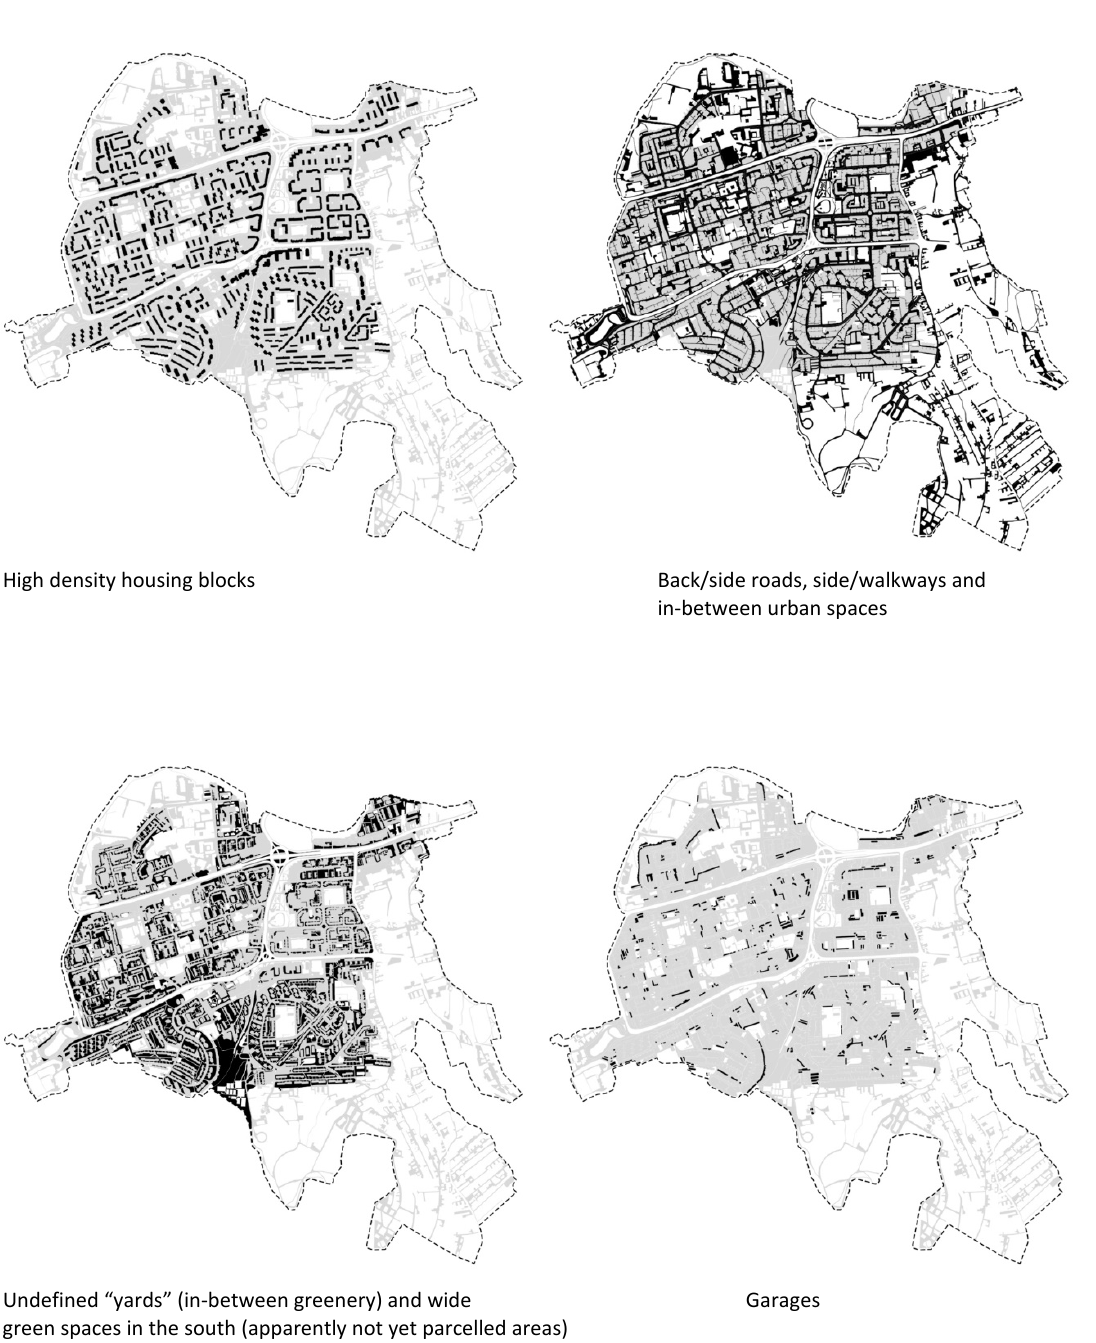
Figure 5: Mănăştur: urban